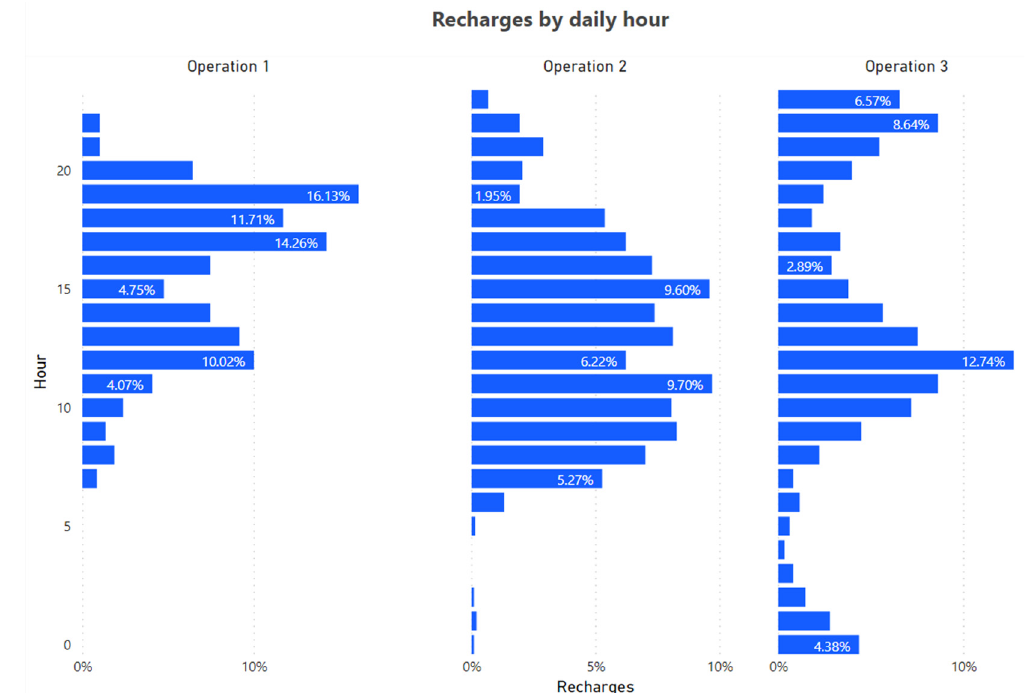
Figure 12. Recharging sessions by daily hour and operation.